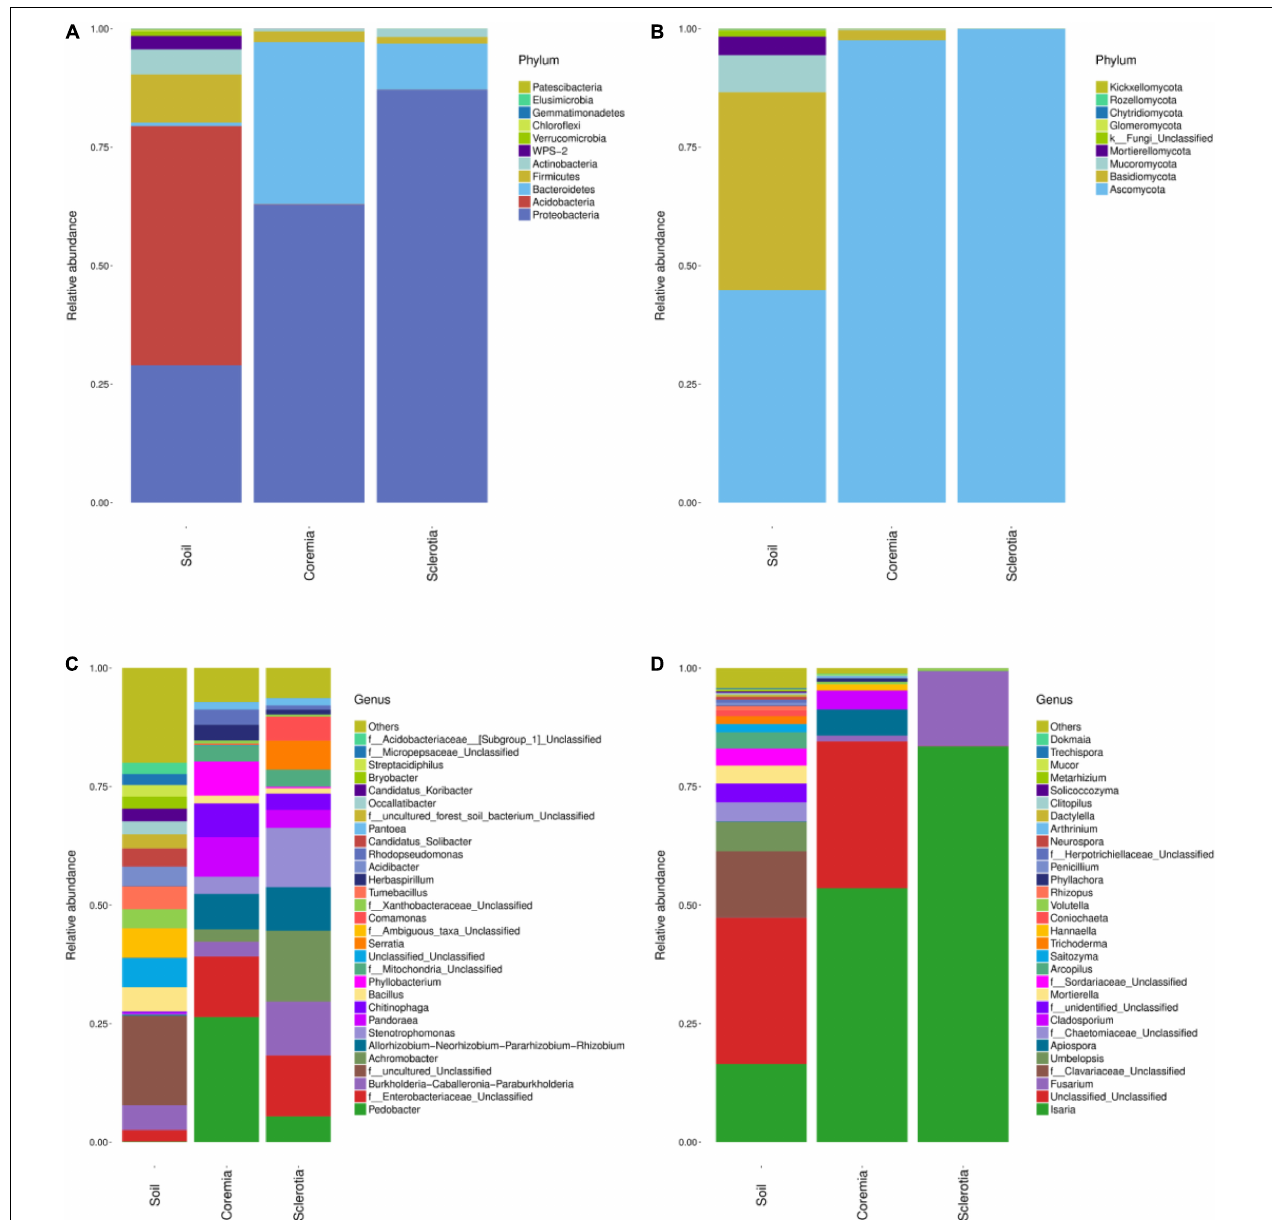
FIGURE 3 | Structure of the endogenous fungal community of cicada flower and its microhabitat samples. (A) Endogenous bacterial community at the phylum level. (B) Endogenous fungal community at the phylum level. (C) Endogenous bacterial community at the genus level. (D) Endogenous fungal community at the genus